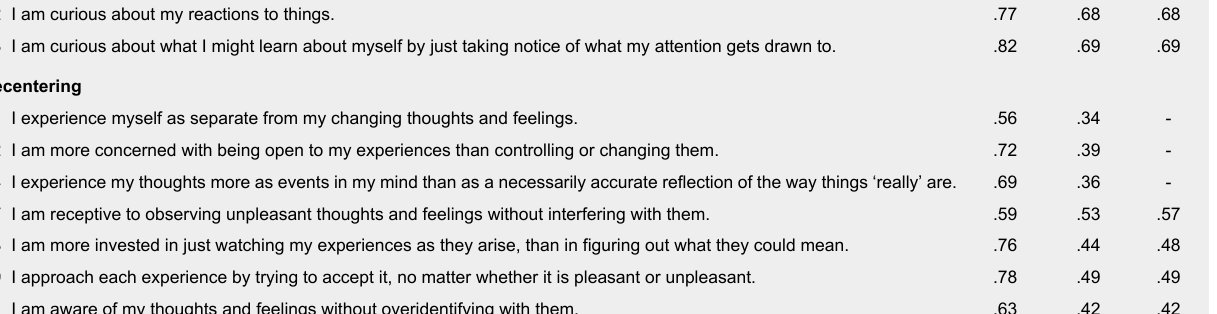
Current Study 10-item model13-item modelLau et al.